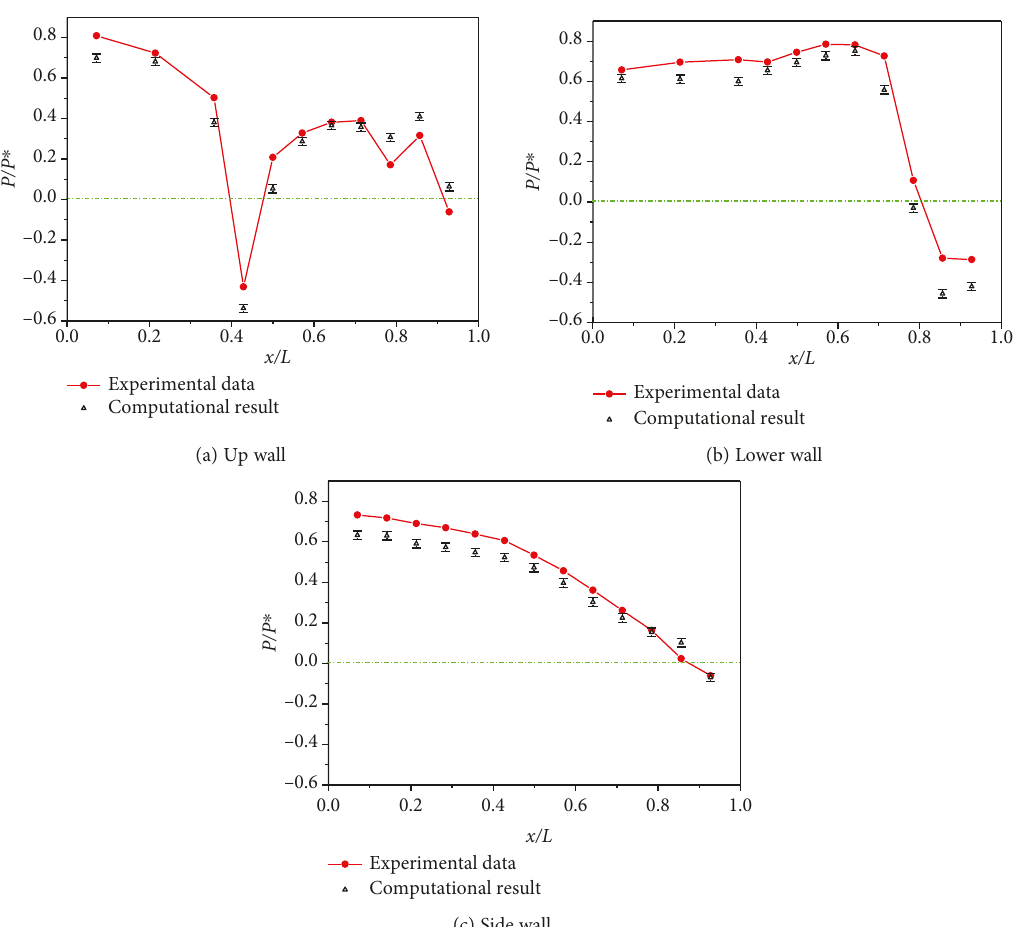
Figure 8: Comparison of experimental and computational results ( S / D = 1 , L / D = 3 5